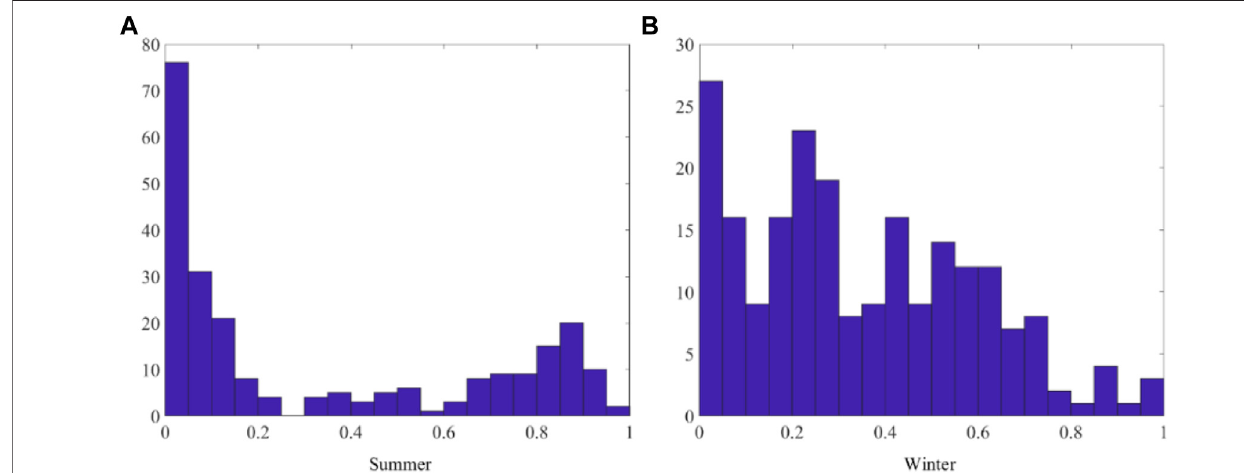
FIGURE 3 | Histogram of energy consumption in summer and winter.